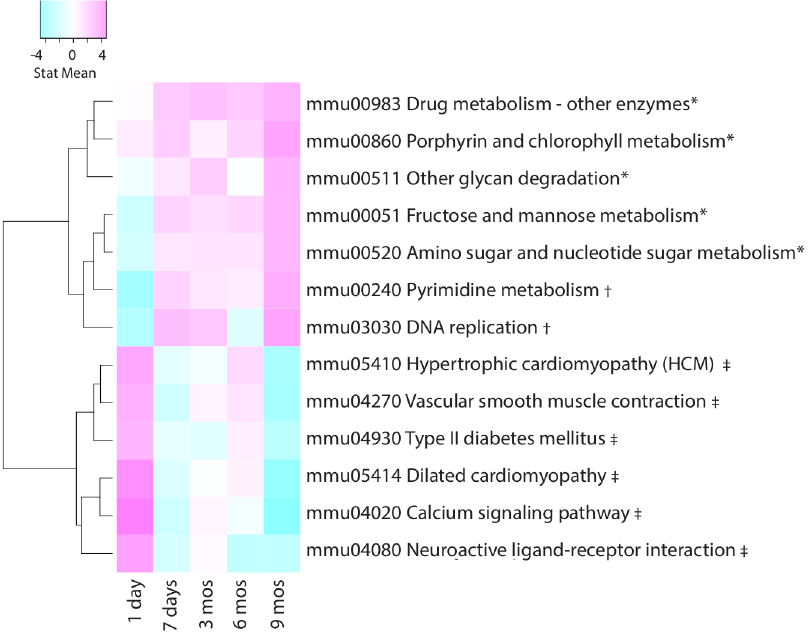
Fig 4. KEGG pathways displaying unique enrichment patterns at 9 months of CS (FDR (cid:20) 0.10). The pathways were either exclusively differentiallyenrichedor exhibitedan oppositedirectionof enrichment